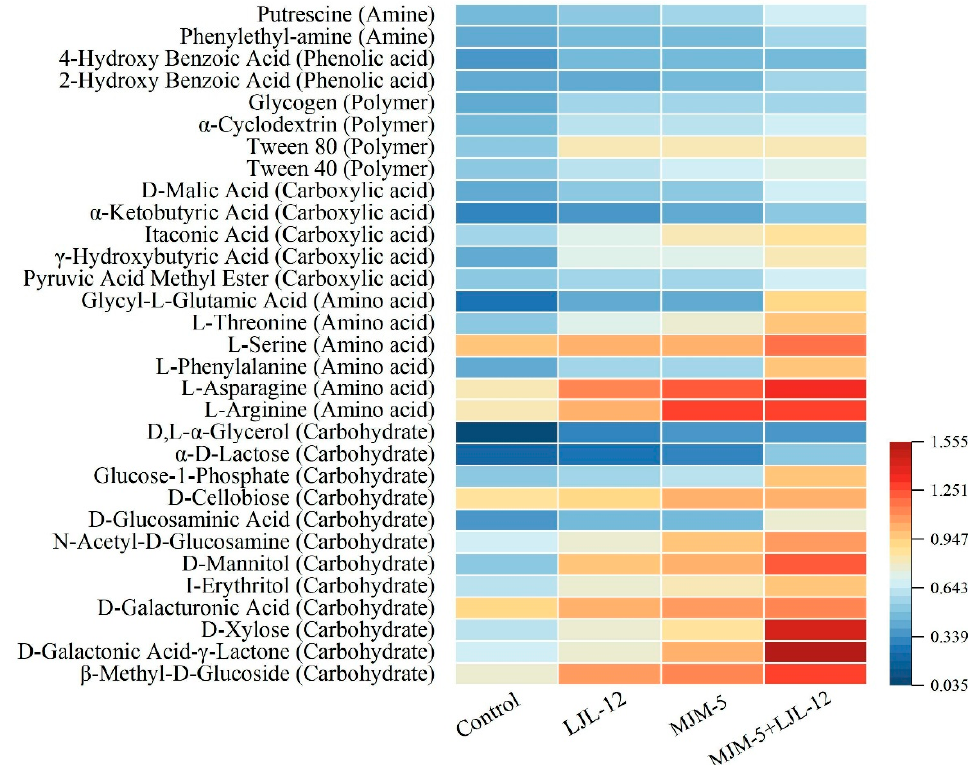
Figure 2. Utilization of 31 carbon substrates by the soil microbial community under Control, LJL-12, MJM-5, and MJM-5+LJL-12 treatments. Different color boxes represent the average optical densities of the microbial community. The color indicator on the right side of the heatmap depicts the alteration in the carbon source availability.